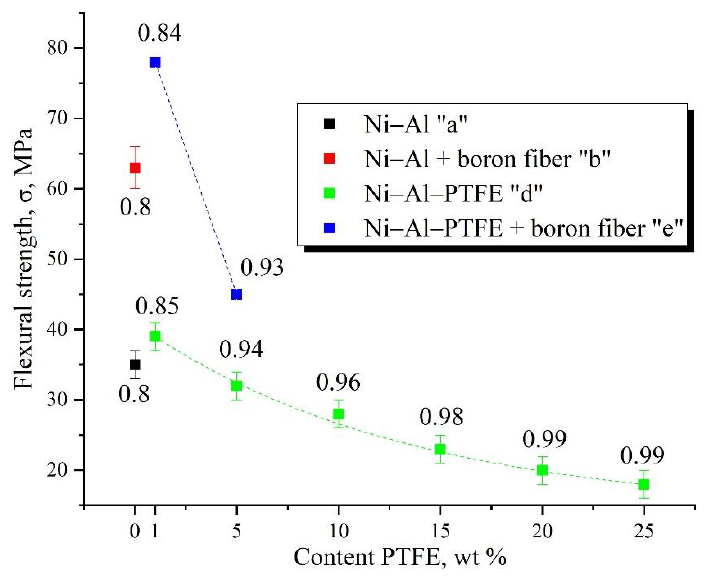
Figure 9. XRD of type a specimens before and after HT.